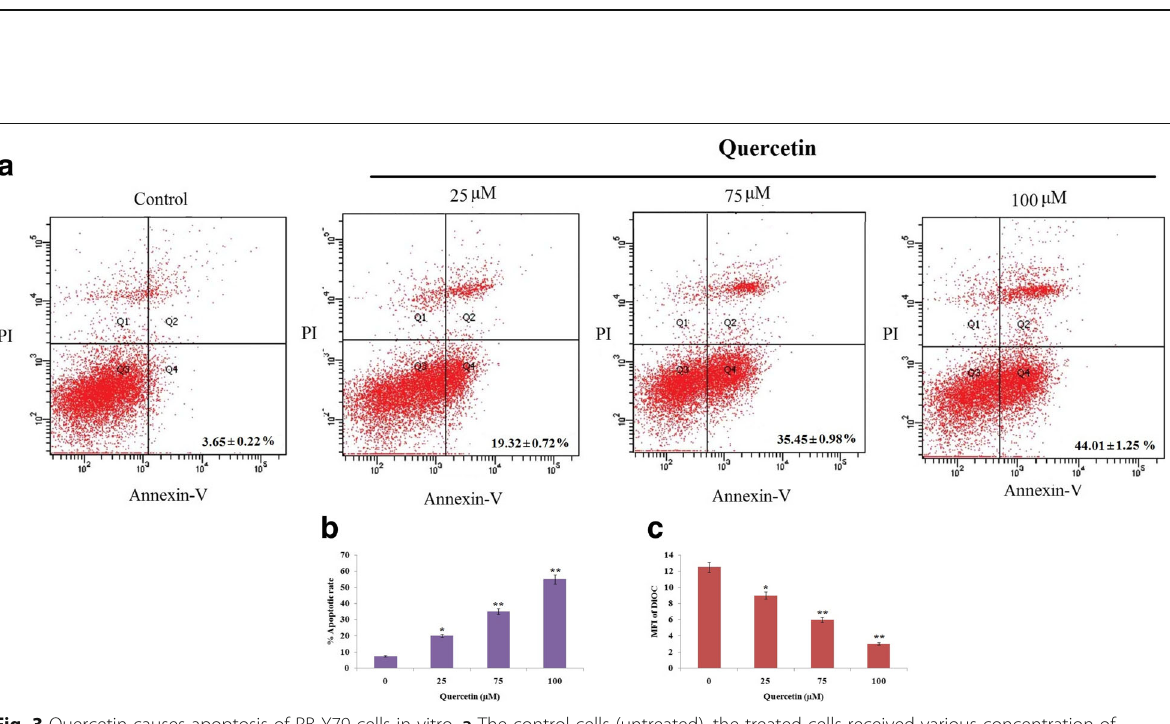
Fig. 2 Quercetin causes arrest of cell cycle in retinoblastoma (RB) Y79 cells in vitro. a distribution of cell cycle of RB Y79 cells after 24 h of treatment with different concentrations of Quercetin (0-100 μ M), all data are represented as the means ± SD ( n = 3). * P < 0.05, ** P < 0.01 against control. b and c Y79 cells were exposed to various concentration of Quercetin (0-100 μ M) and the obtained cell lysates after 24 h were subjected to western blot analysis employing specific antibodies against cyclin-dependent kinase (CDK)2, CDK6, p27, cyclin D3 and p21, GAPDH was used as a loading control. The results are represented as means ± SD ( n = 3). * P < 0.05, ** P < 0.01 against control. @P < 0.05 against Quercetin (50 μ M) group